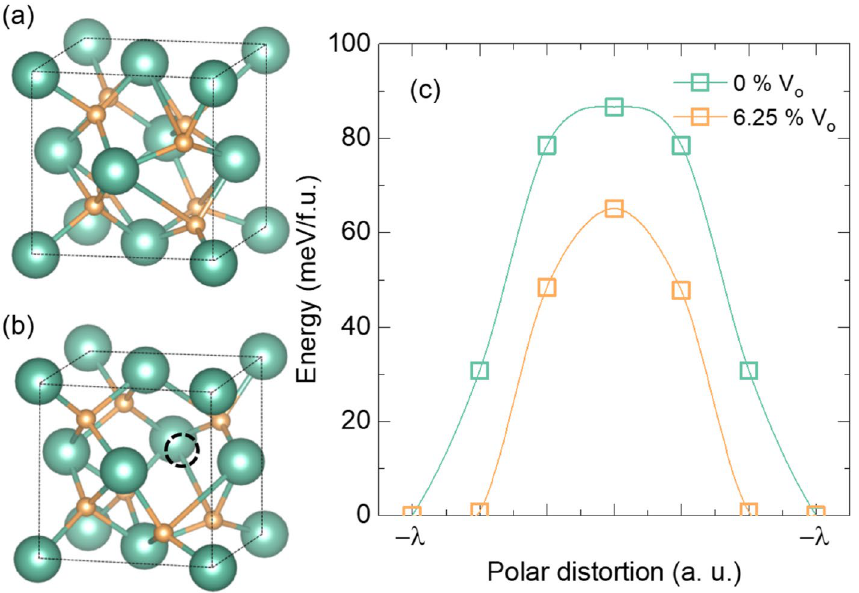
Figure 5. Schematic diagram of orthorhombic HfO 2 ( a ) without oxygen deficiency and ( b ) with 6.25% oxygen deficiency. ( c ) First-principles calculations of the energy landscape during single ferroelectric dipole flipping for 0% and 6.25% oxygen deficiency